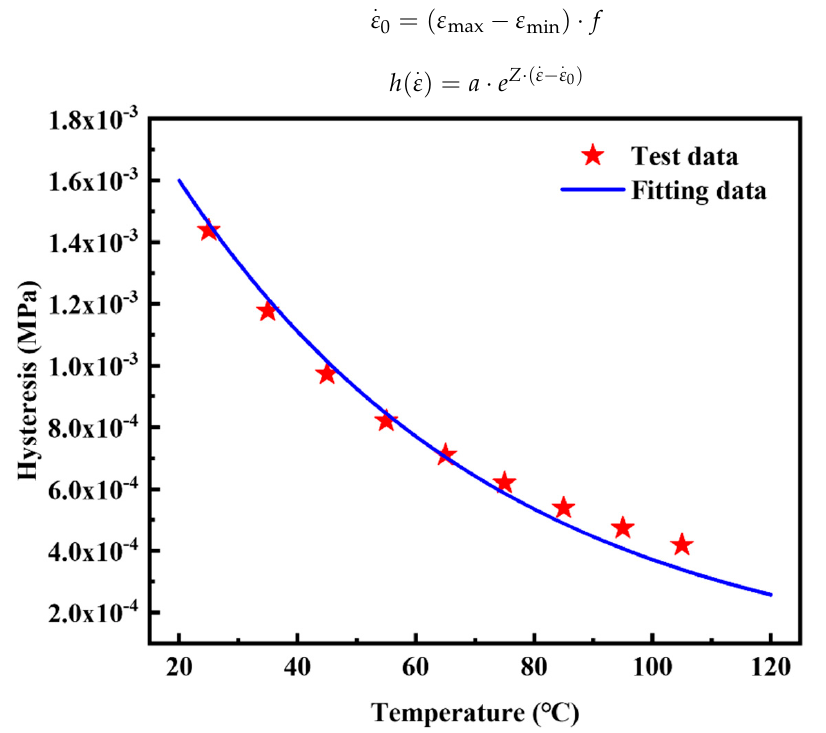
Figure 11. Test data of h vs. θ and fitting data of the silica filled S − SBR material at a constant strain amplitude of 20% and a constant frequency of 10 Hz. The coefficient of determination R 2 is 0.9774.